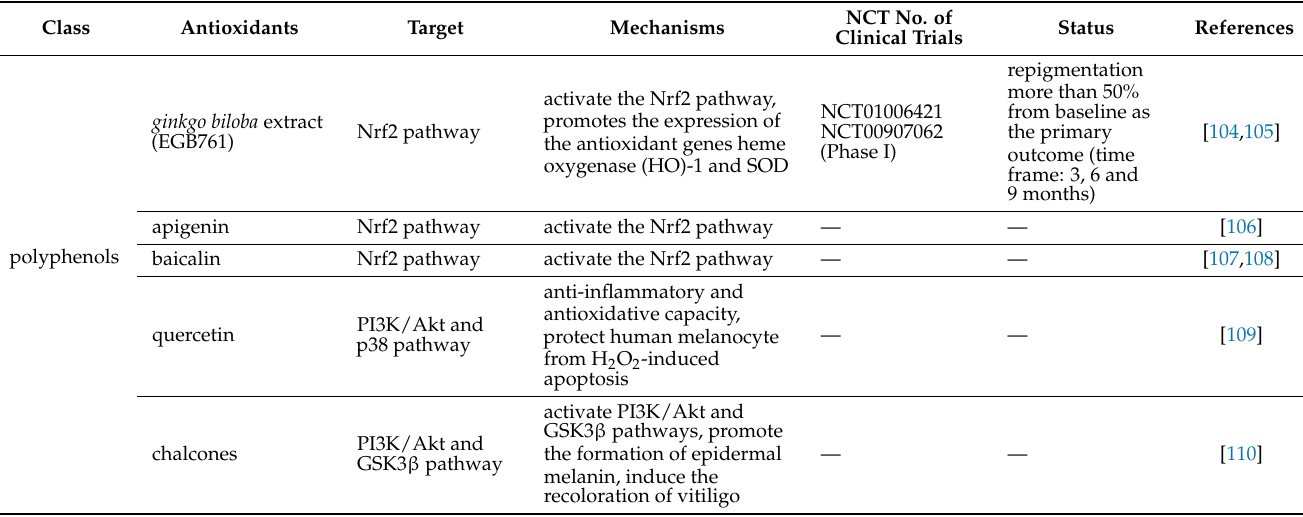
Table 2. Potential therapeutic approaches targeting antioxidant